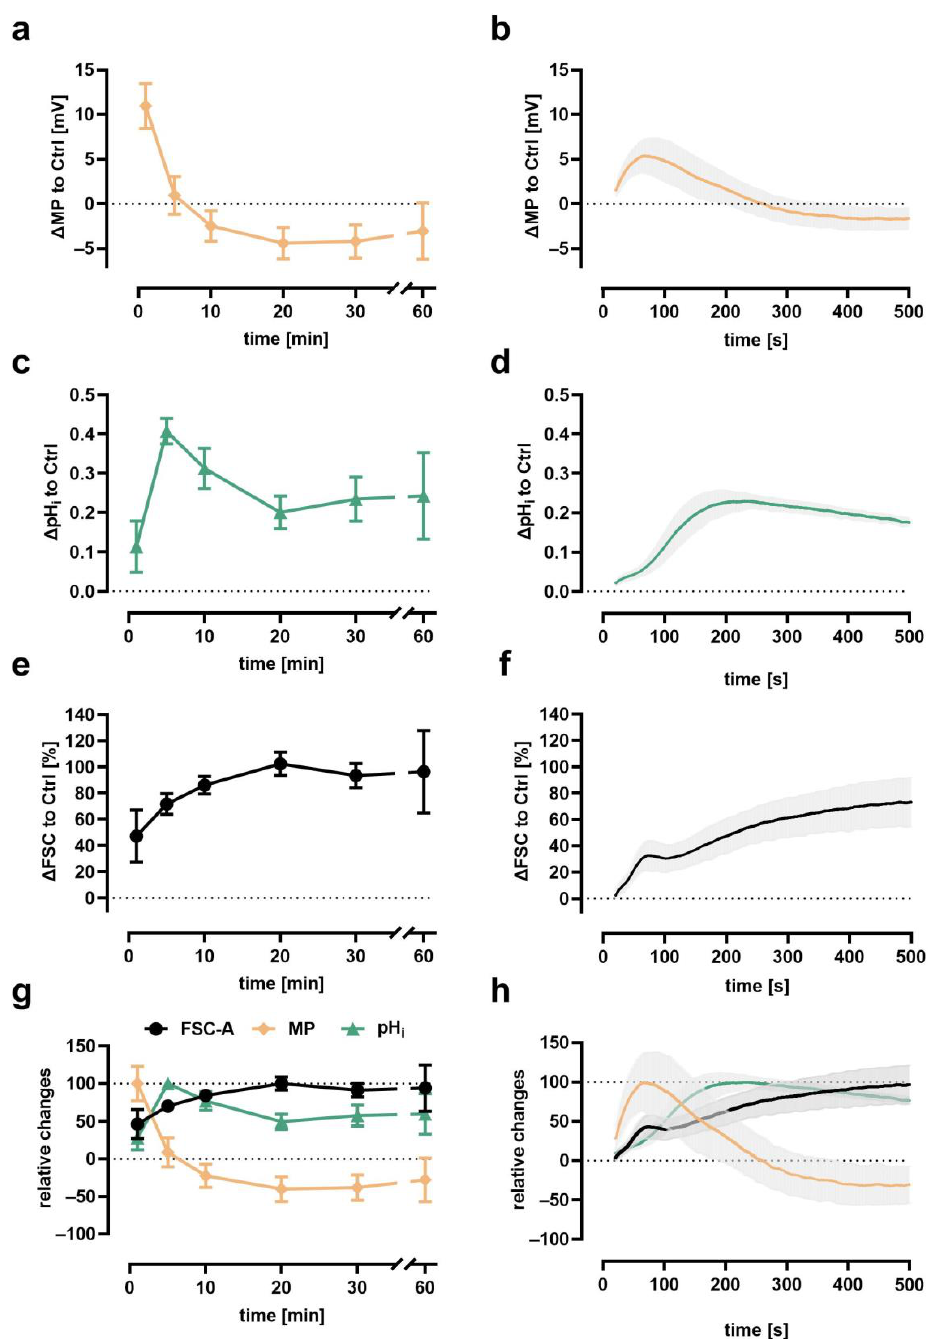
Figure 3. Multiparametric time course of the response of neutrophils after fMLF stimulation by conven- tional measurement (the same tube measured at multiple time points as indicated, left panel, n = 16) or near realtime measurement (the same tube acquired for 500 s after stimulation, right panel, n = 6). Synchronous quantification of ( a , b ) depolarization, ( c , d ) alkalization, and ( e , f ) change in cellular size in neutrophils after stimulation with fMLF; ( g , h ) summarize the time course of the multiparametric analysis normalized to baseline (0%) and maximal effect (100%). n = 5–15, grey areas indicate the standard